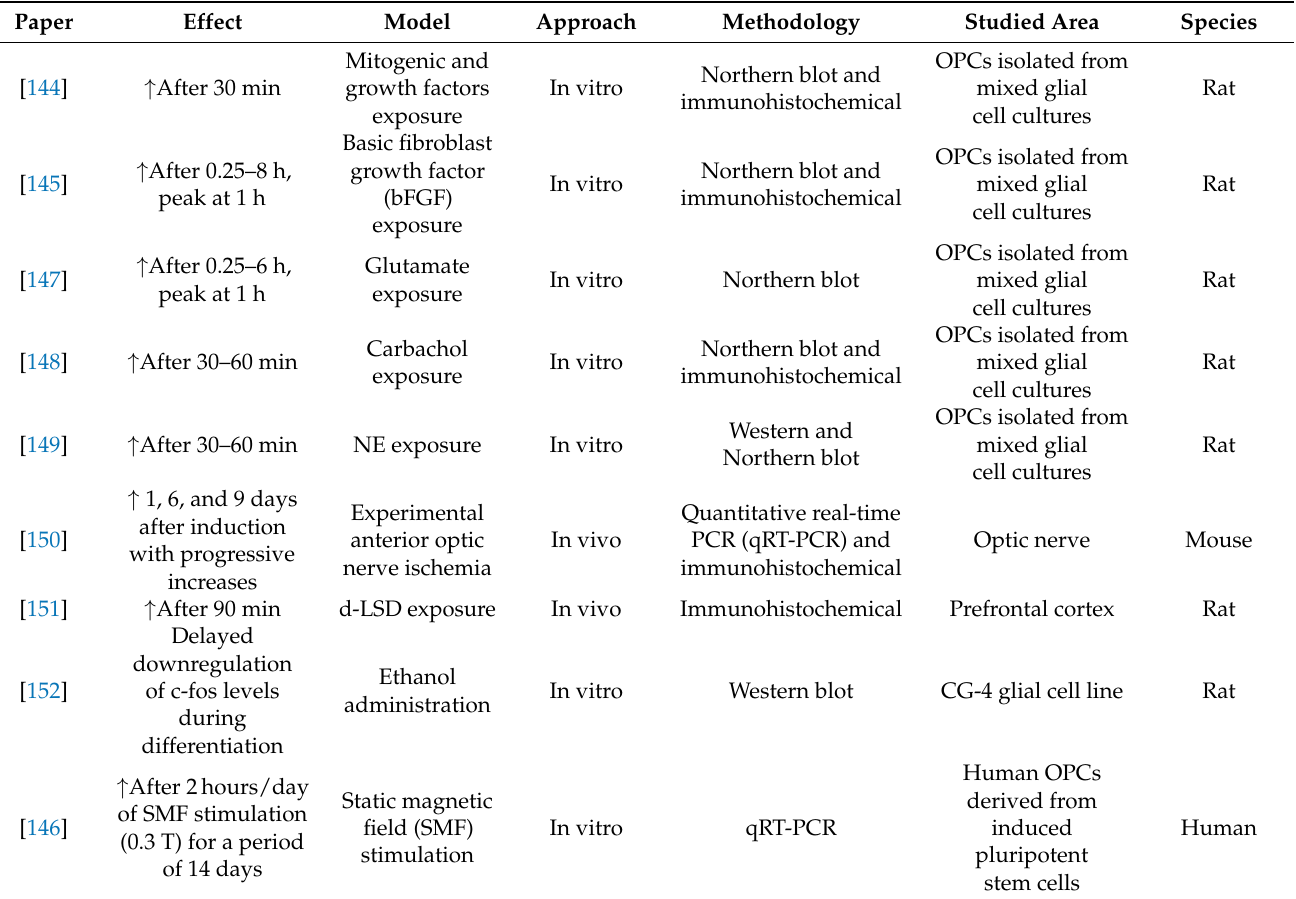
Table 2. Papers evidencing c-fos expression in